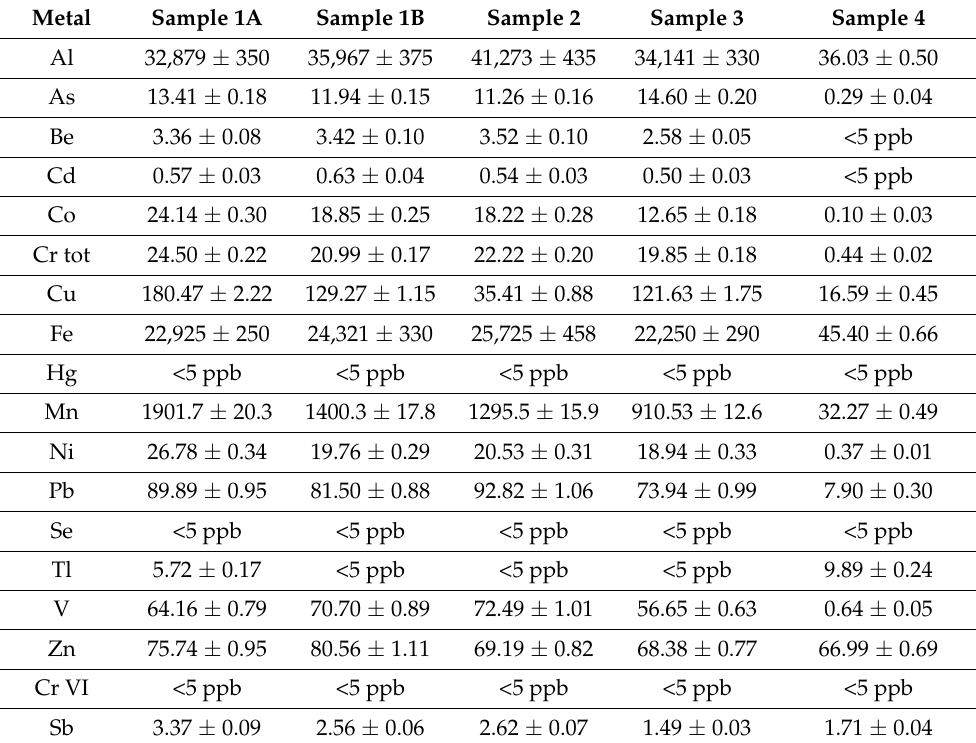
Table 2. Analysis of soil samples: listed values (as ppm) are means of triplicate determination ±